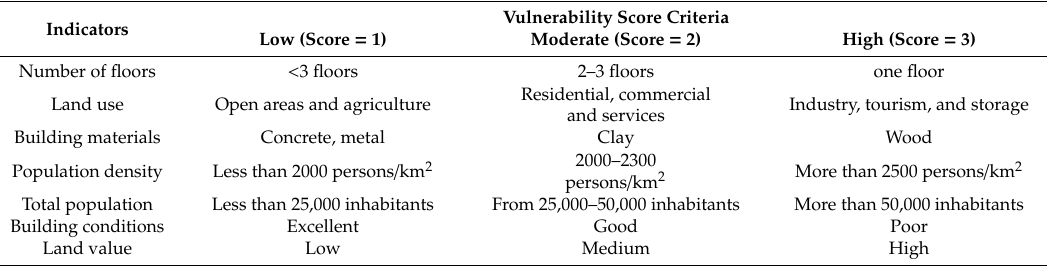
Table 4. Scoring criteria for the vulnerability indicators.